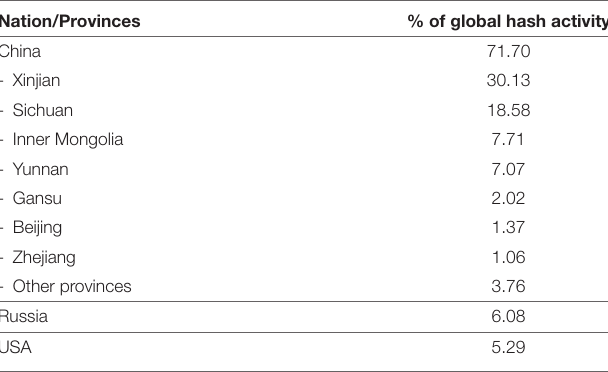
TABLE 3 | Geographic distribution of the share of hash rate on the Bitcoin network,